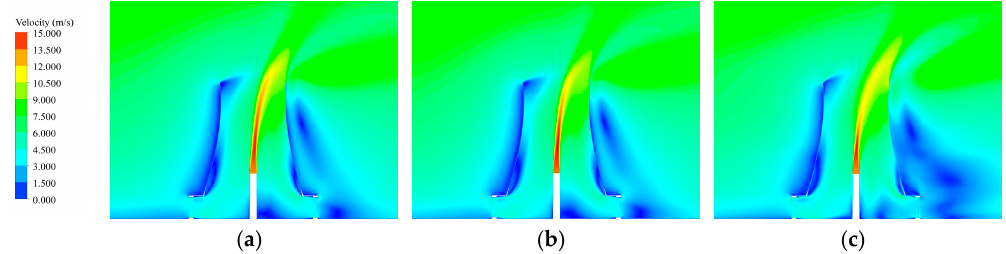
Figure 8. Comparisons of velocity magnitude distribution at vertical plane (y = 0 m) in NDDCT with flue gas injection: ( a ) RANS; ( b ) URANS; ( c ) LES.